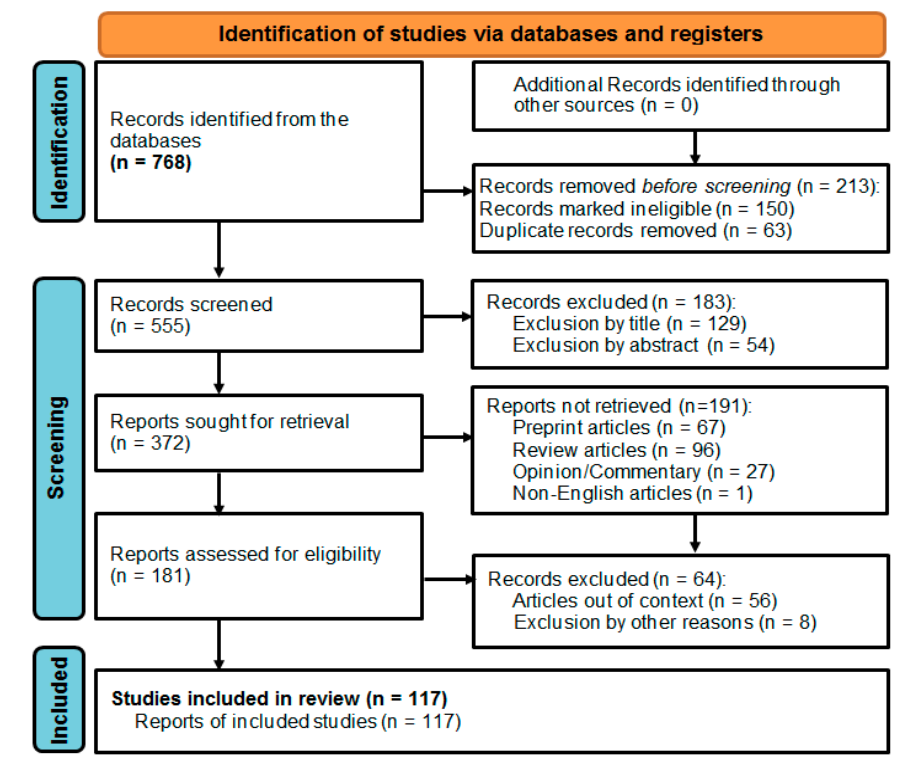
Figure 1. Flow diagram for the scoping review study following PRISMA guidelines [47].